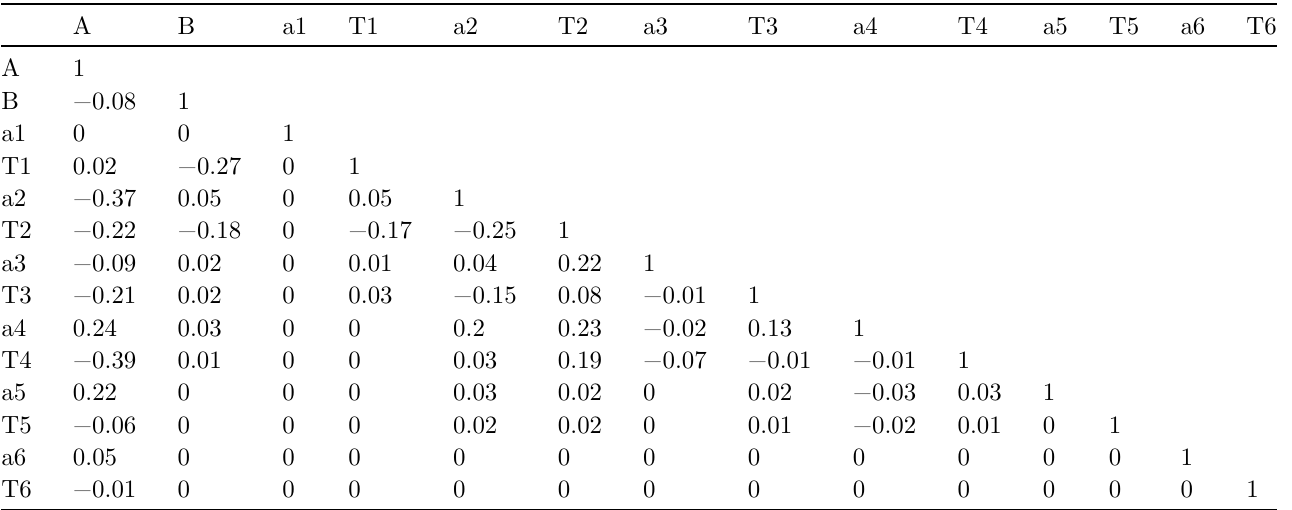
, T ) ( A = 1000, B = 100). i i